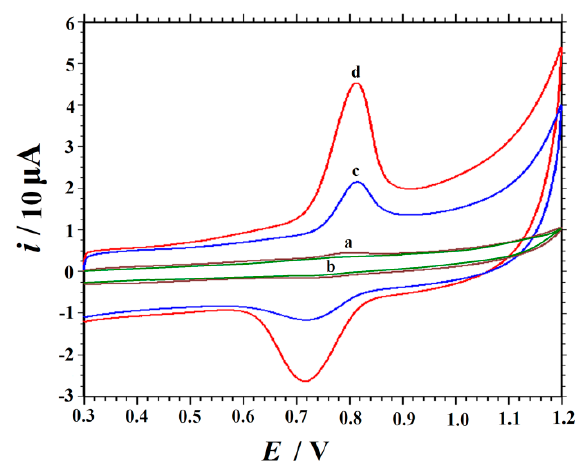
Figure 3. Cyclic voltammograms of 0.1 mM SY recorded at GCE ( a ), GO/GCE ( b ), ERGO/GCE ( c ) and MnO 2 NRs-ERGO/GCE ( d ) in 0.3 M citric acid-sodium citrate buffer (pH 4.5), scan rate 0.1 V/s.